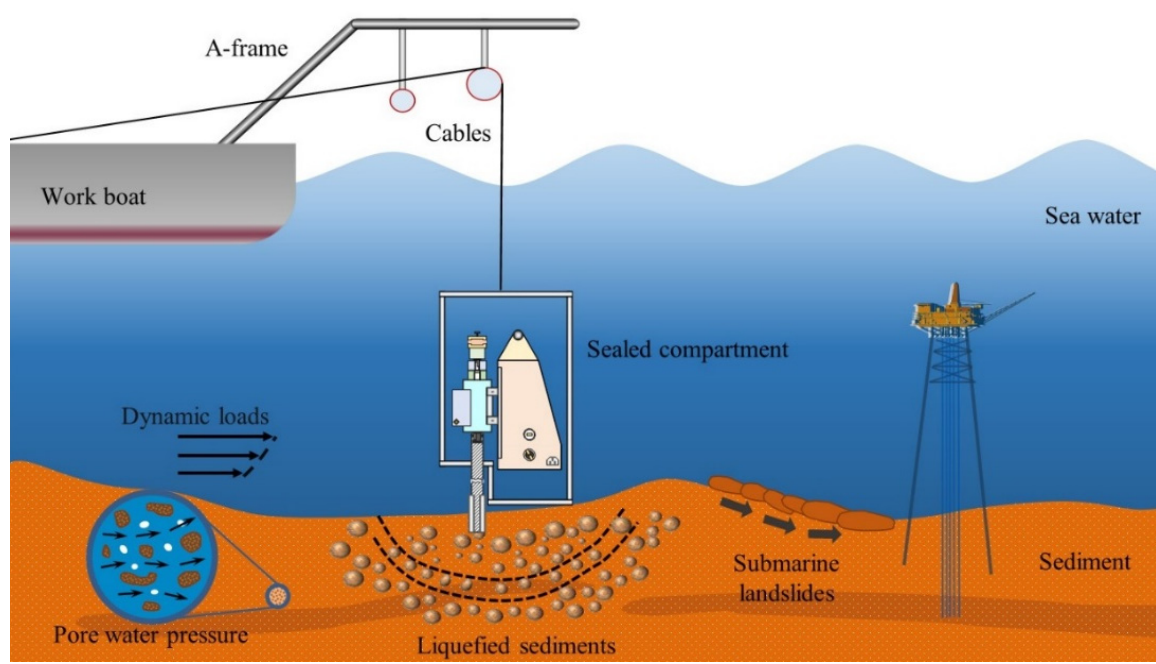
Figure 5. Schematic of the in situ test device work in the offshore area. Note this figure is not to scale.